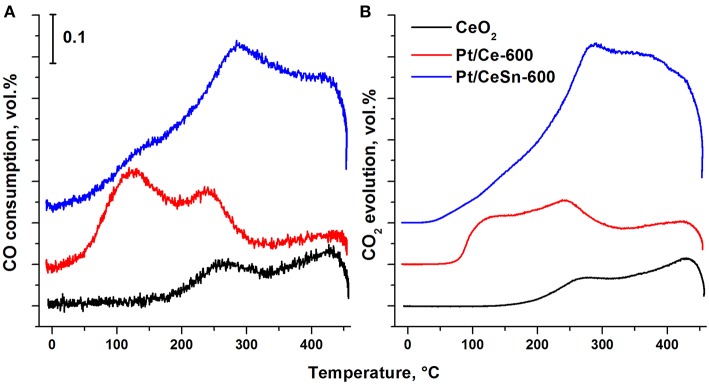
Temperature dependence of the CO consumption (A) and CO2 evolution (B) during the TPR-CO for the catalysts Pt/Ce-600, Pt/CeSn-600 and pristine CeO2-600.